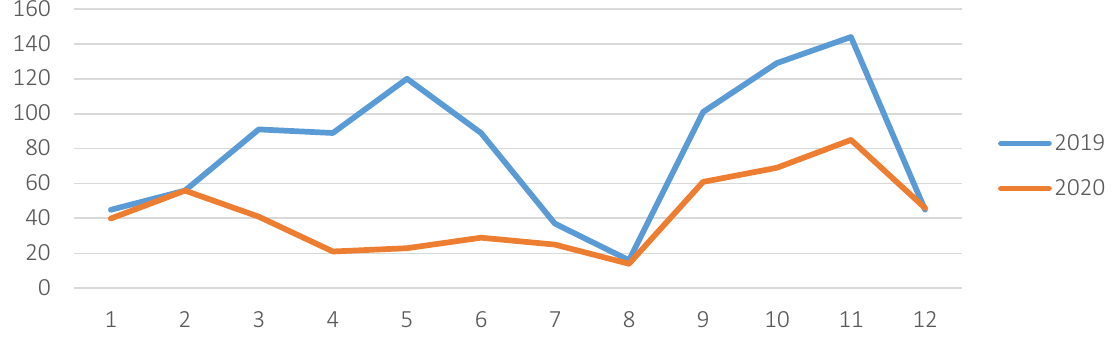
Figure 3. Distribution of the number of events by months in 2019 and 2020 according to the EEN event